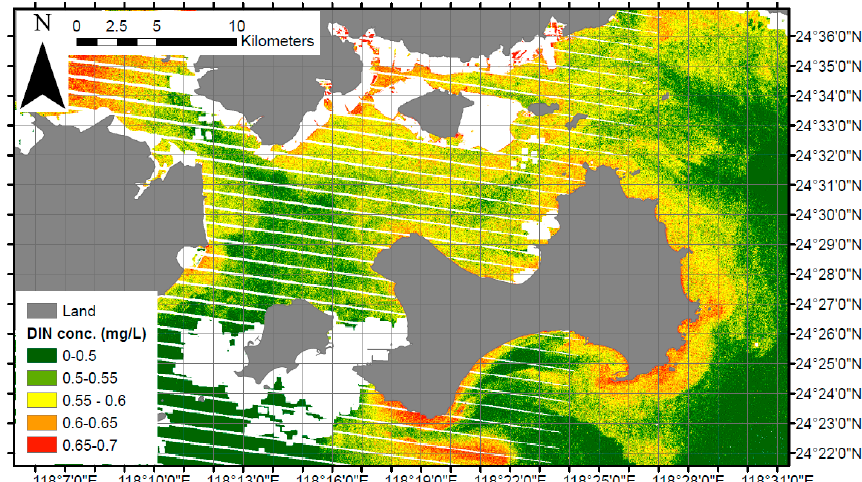
Figure 8. Distribution of DIN concentration on 10 August 2018 derived by the model of Table 6.